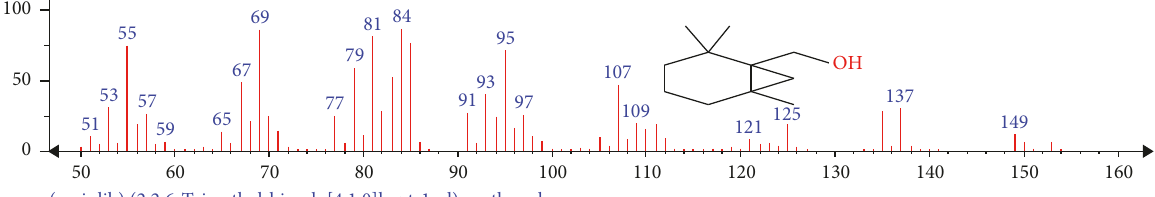
(2,2,6-Trimethyl-bicyclo[4.1.0]hept-1-yl)-methanol50 60 (mainlib) Figure 8: Mass spectrum of compound 2,2,6-trimethyl-bicyclo[4.1.0]hept-1-yl-methanol of whole plant hexane fraction of Achillea wilhelmsii (WHFAW).